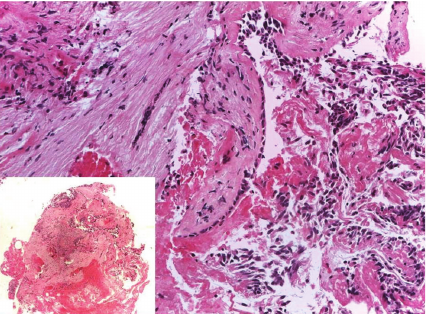
Figure 2: The specimen of bronchial mucosa obtained by human bronchoscopic biopsy 60 days after stem cell implantation showed a discrete coarctation induced by sample taking (left lower box); however it was possible to appreciate hyperplastic respiratory epithelium lying on a diffusely fibrotic lamina propria. Bands of smooth muscle fibers were reduced and replaced by